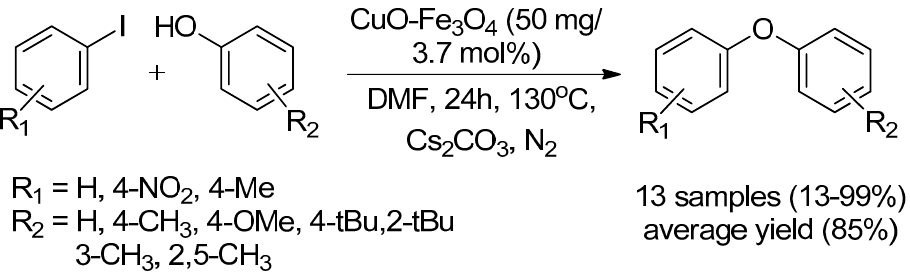
Scheme 14. Maghemite-Copper oxide nanoparticles catalyzed synthesis of biphenyl